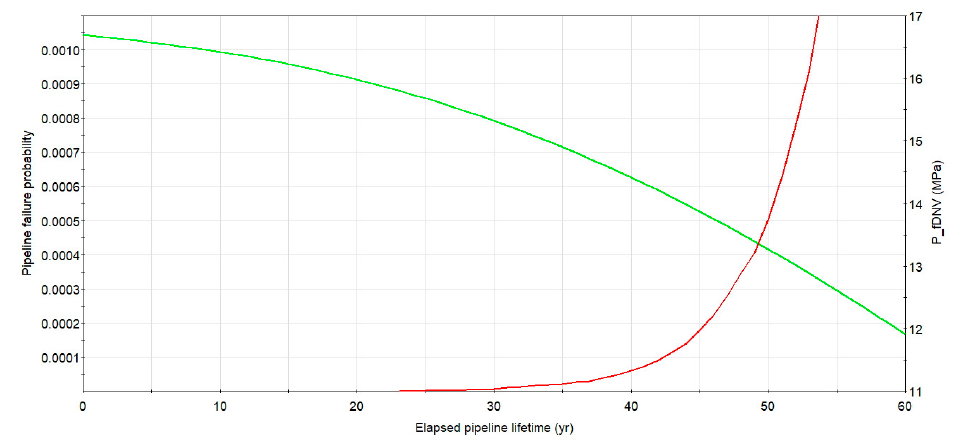
Figure 9. Change of burst pressure and failure probability with time for L360NE DN 700 MOP = 5.5 MPa pipeline with metal loss group 2. Source: Author’s analysis.